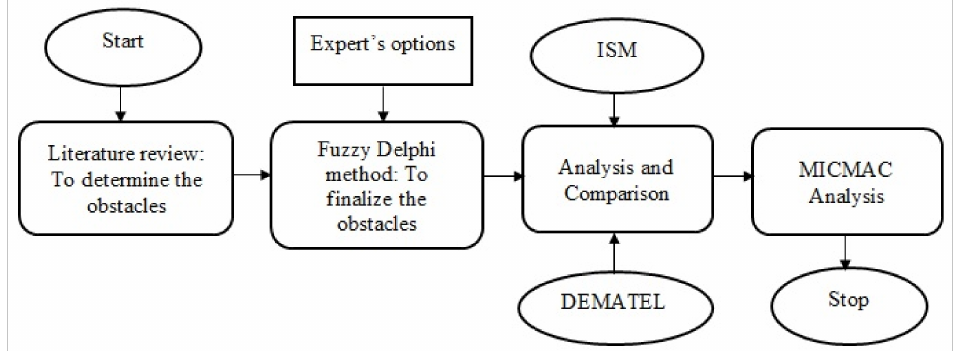
Figure 1. Research flow of the present